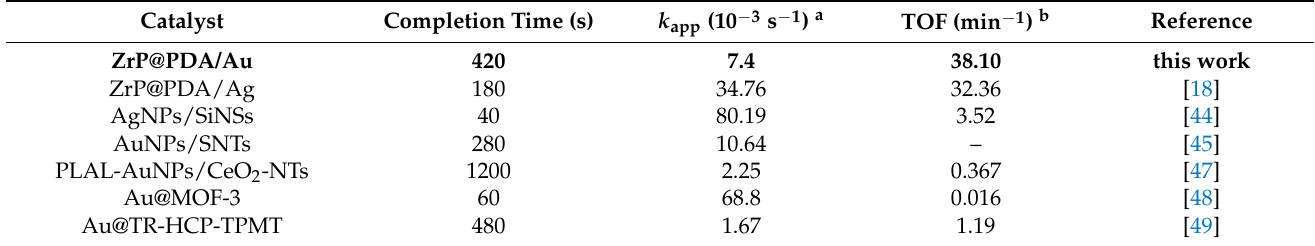
Table 1. Catalytic activities of various supported noble metal